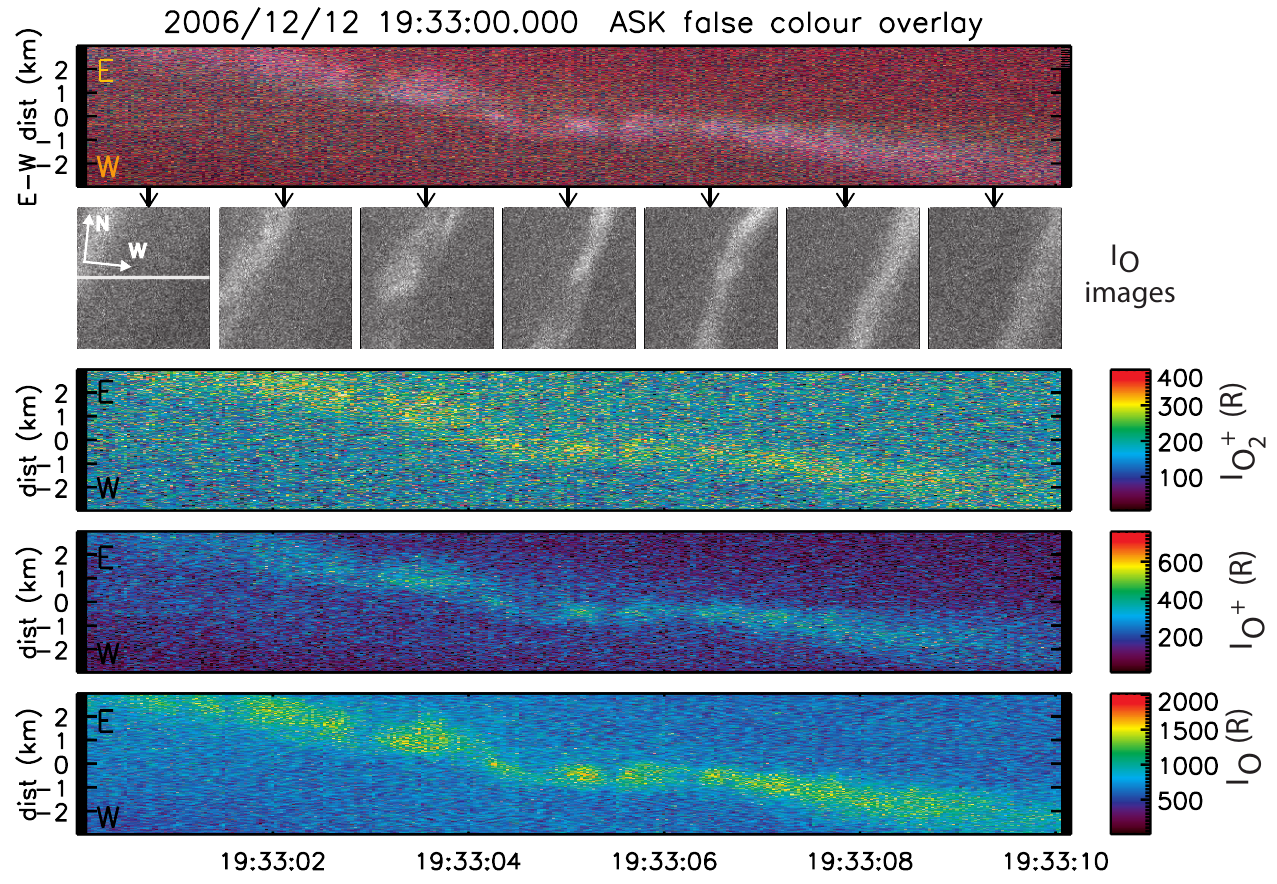
Fig. 3. ASK keograms from the arc passing the FOV at 19:33 UT. The bottom three keograms are from ASK1 (I ASK3 (I O ), and the top keogram is a colour-coded (red-green-blue) overlayed keogram of the three channels. All keograms are made from east-west aligned cuts through the images. I O images for different times are shown below the overlayed keogram.